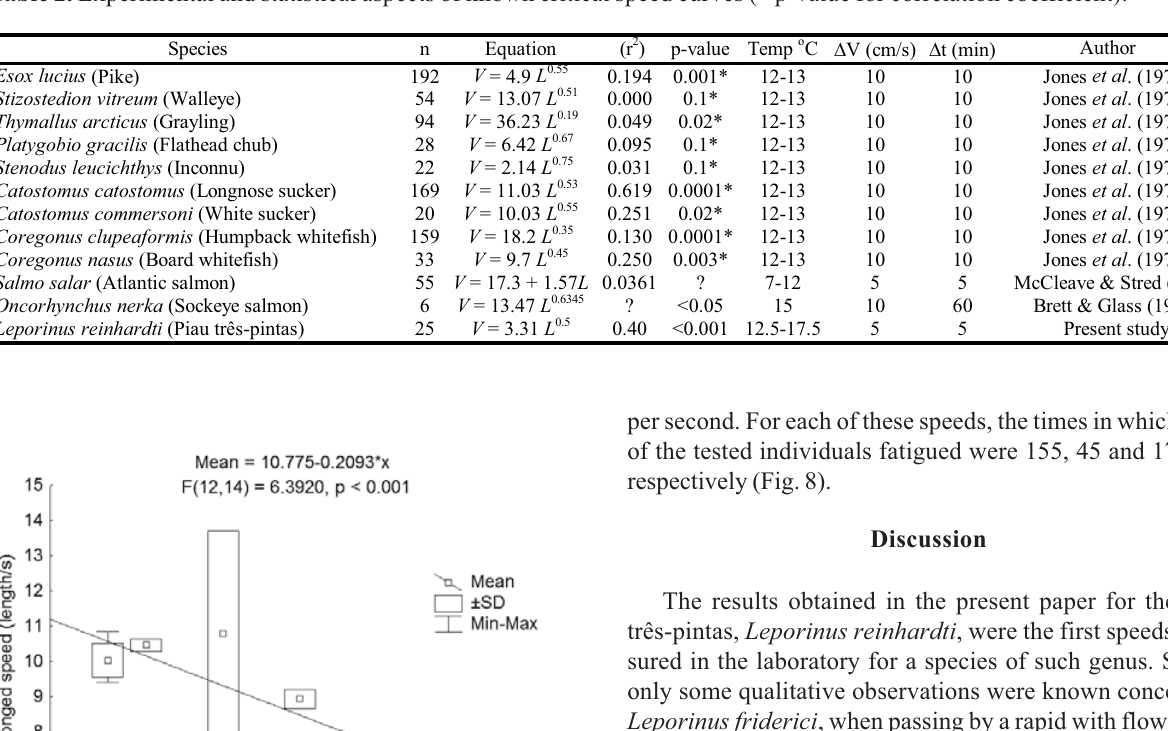
Table 2. Experimental and statistical aspects of known critical speed curves (* p-value for correlation coefficient).